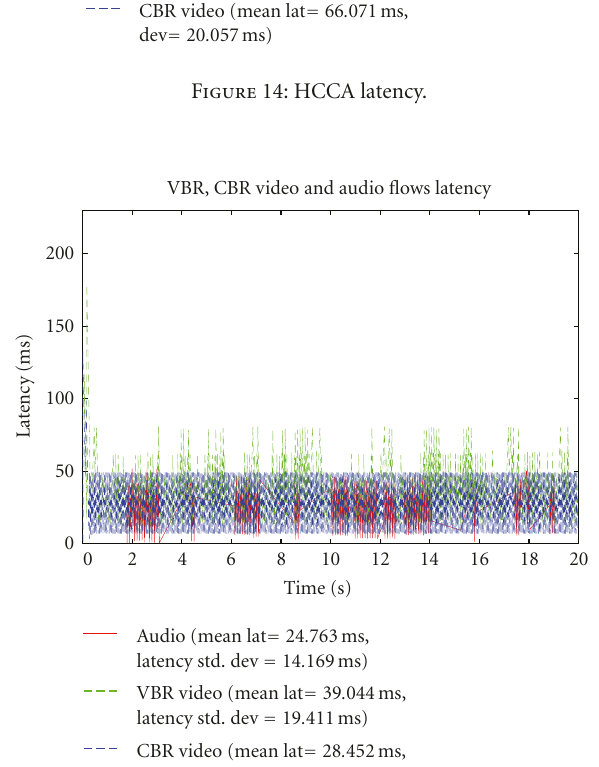
Figure 16: EDCA latency.